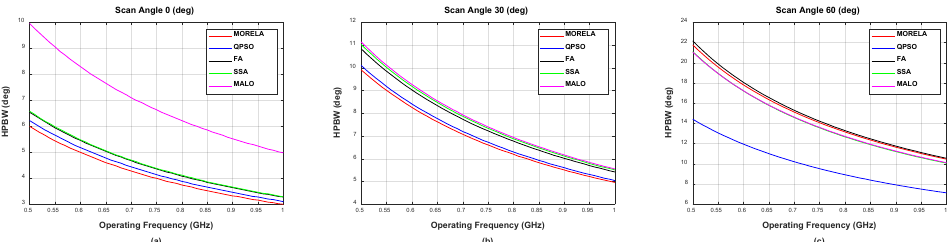
Figure 6. The HPBW performance of symmetric NUSLA in the case for ( a ) θ 0 = 0°, ( b ) θ 0 = 30°, and ( c ) θ 0 =